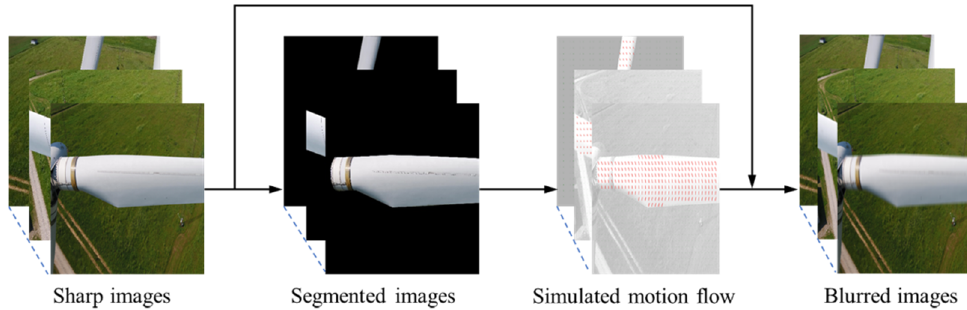
Figure 6. The image pair synthesis process.